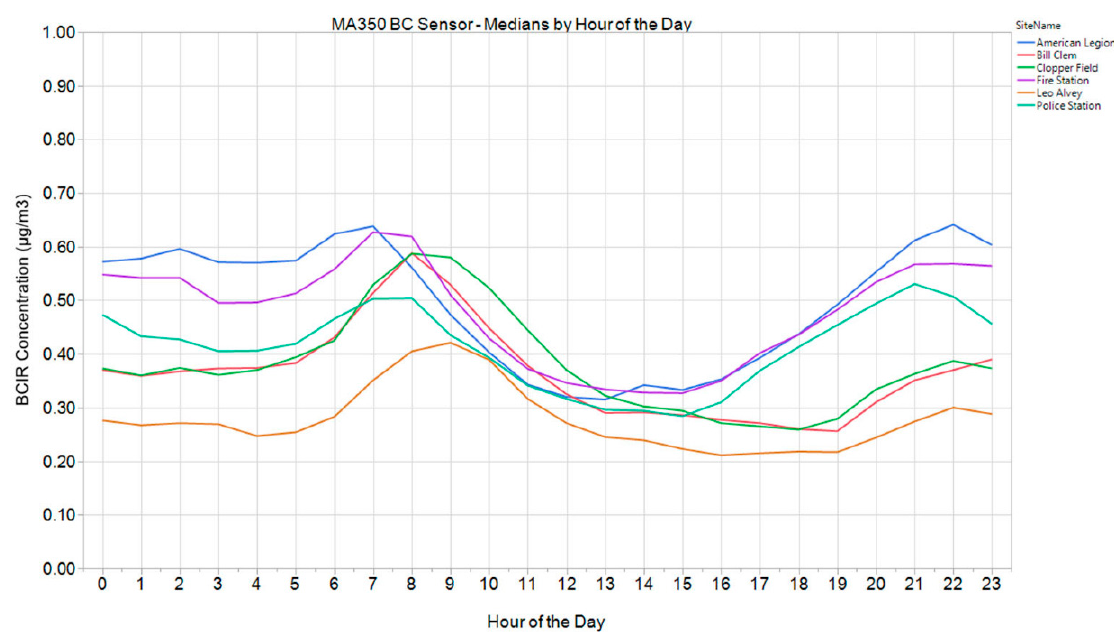
Figure 9. Diurnal Median BCIR Concentrations (µg/m 3 ).